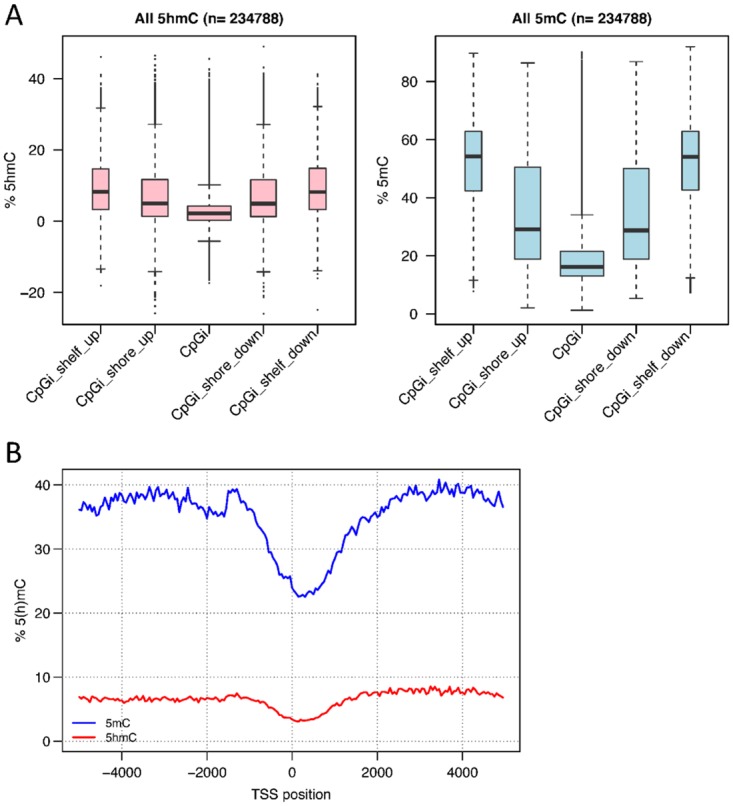
Genomic distribution of 5mC and 5hmC.6a: Distribution of 5hmC and 5mC levels at CpG islands, shores (0–2 kb) and shelves (2–4 kb). 5mC levels show a steep rise moving away from CpG sites, 5hmC levels are lowest at CpG sites but show less variation between shores and shelves. The width of the boxes is proportional to the number of underlying probes. 6b: Distribution of 5mC and 5hmC levels around the TSS. Levels of both types of methylation rise steeply moving away from TSS’s.